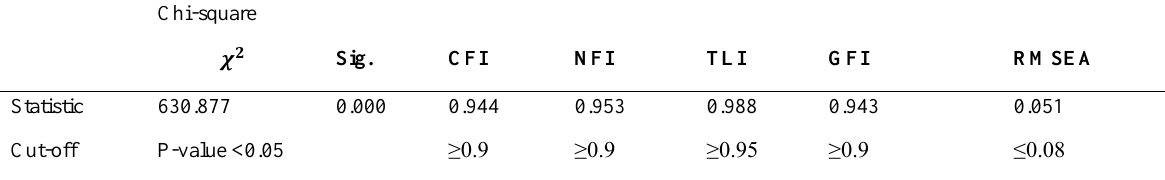
Table 1: Model fit indices for the reliability SEM